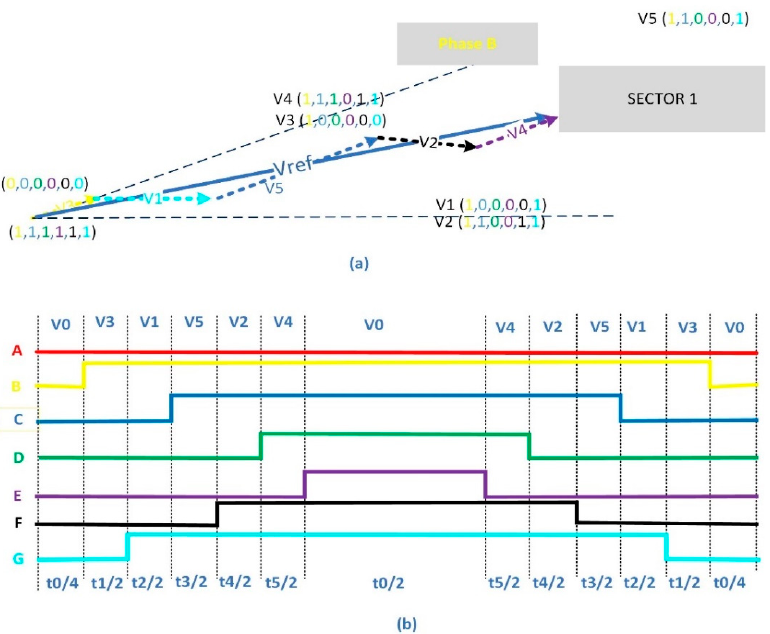
Figure 10. Illustration of how the adjacent active vectors are used to synthesis V_ref in the first sector using the new SVPWM after losing phase ‘A’. ( a ) active switching sequence. ( b ) PWM waveform. The application time of the active vectors V1, V2, V3, V4, V5 and V0 i.e., ( t 0, t 1, t 3, t 3,